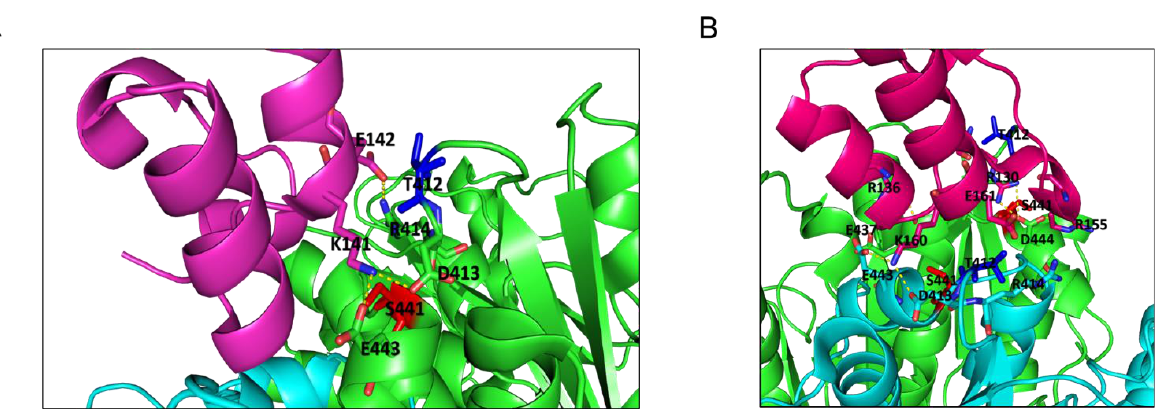
Figure 7. Interactions between human DLD and E2b (panel A) and E3BP (panel B). ( A ) In green ribbon, human DLD; in magenta, E2b (PDB: 3RNM); in red and blue sticks, S441 and T412, respectively; in yellow dots, salt bridges. Phosphate groups on T412 and S441 residues may increase the number of negative charges close to K141, stabilizing the interaction. ( B ) In green and cyan ribbon, human DLD chain A and chain B, respectively; in magenta, E3BP (PDB: 2F5Z); in red and blue sticks, S441 and T412, respectively; in yellow dots, salt bridges between R130 (E3BP) and D444 (DLDH), R136 (E3BP) and E437 (DLDH), R155 (E3BP) and D444 (DLDH), K160 (E3BP) and E443/D413 chain B (DLDH). Phosphate groups on S441 residue on chain A and B may create novel interactions with K160 and R130 respectively; negative charge on T412 may instead modify the orientation of the residue side chains of the loop.